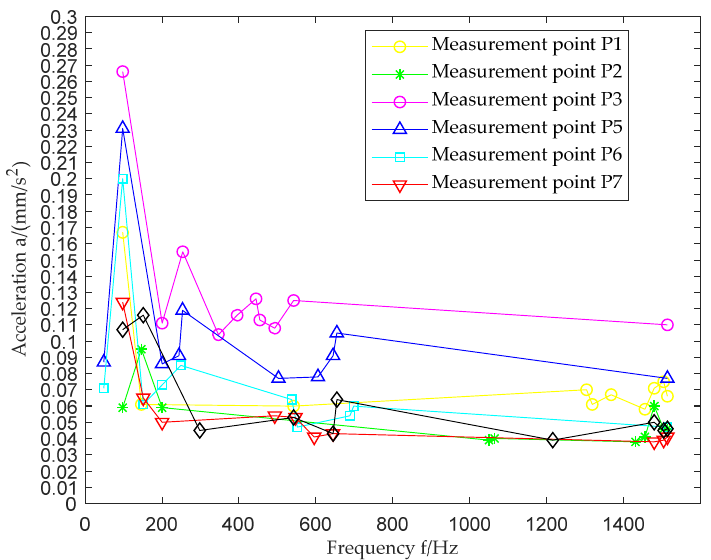
Figure 26. Vibration acceleration spectrum analysis of measurement points 1–7.